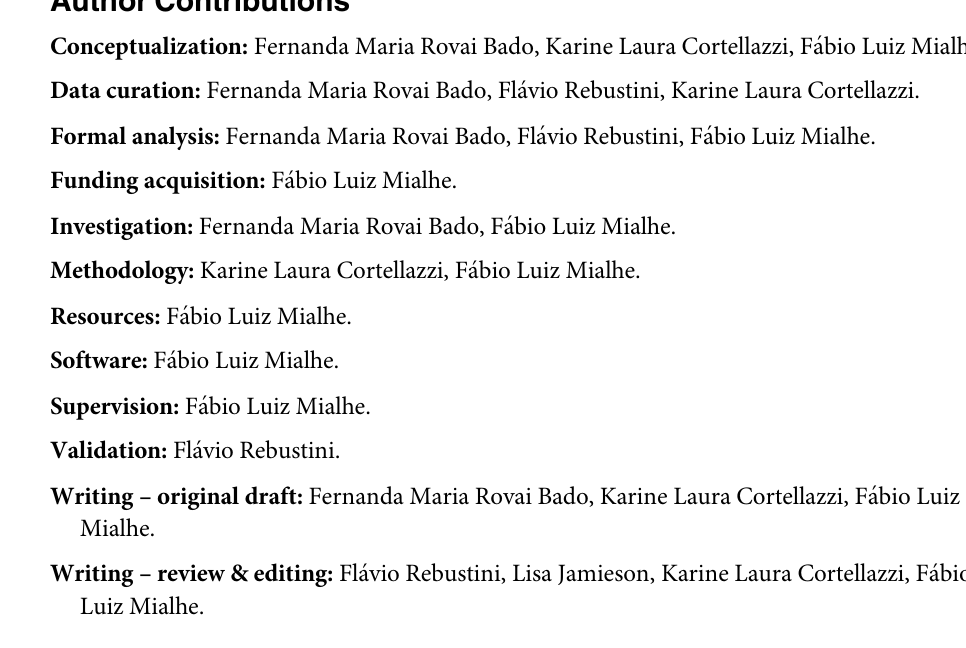
S1 Table. Comparison between REALD-30, the recommended OHLA-S version with 24 items and the initial version of